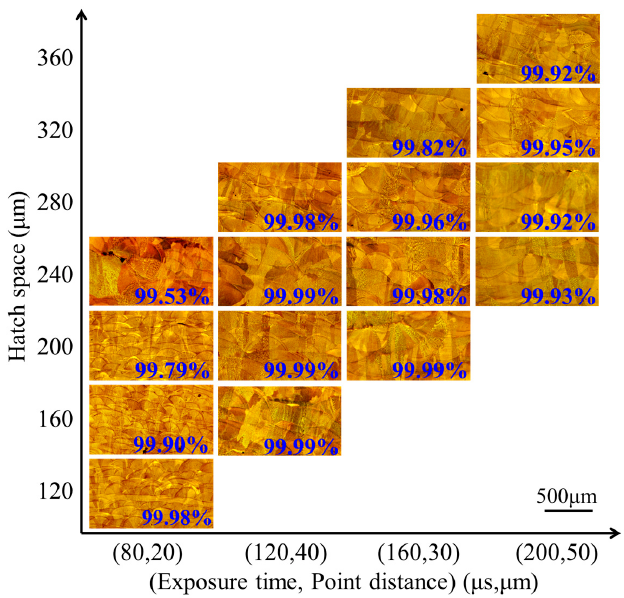
Figure 5. Relative density of multi-layer fabrication.